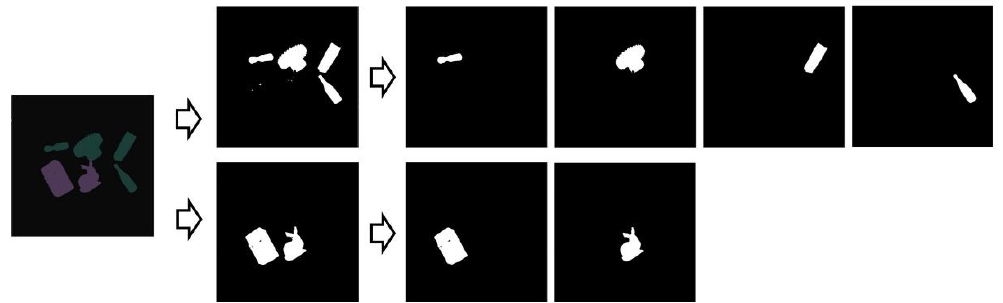
Figure 6. The image is splatted into clusters and connected components labeling is applied to separate each object.